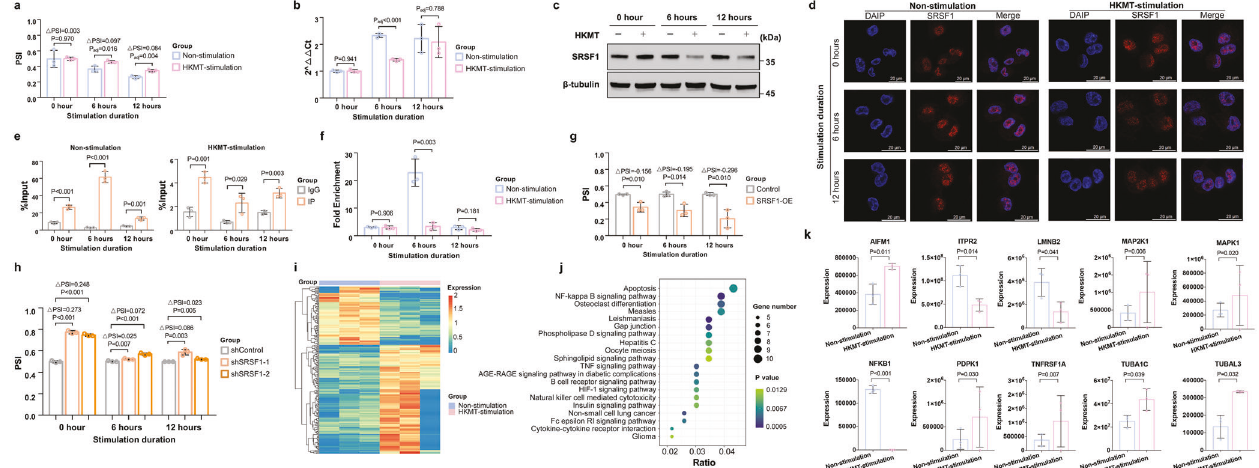
Fig. 5 Regulation of SRSF1 on UBE2B-exon7-SE in tuberculosis. a , b qRT-PCR results showing the UBE2B-exon7-SE splicing and SRSF1 mRNA expression in macrophages with and without HKMT stimulation, respectively. ( n = 3 biologically independent samples). Data are represented as mean ± standard deviation. P adj was calculated by adjusting the splicing state of macrophages at the 0 h time point. c Western blotting results showing SRSF1 level in macrophages with and without HKMT stimulation. d Immuno fl uorescence staining of SRSF1 (red) and